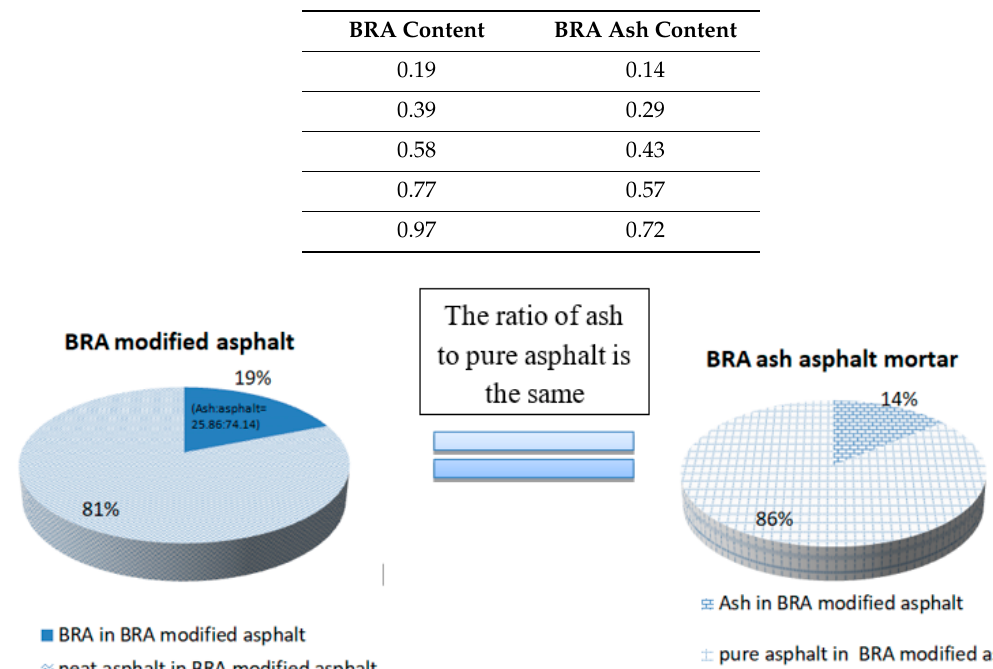
Table 4. Buton rock asphalt (BRA) and BRA ash content comparison table.